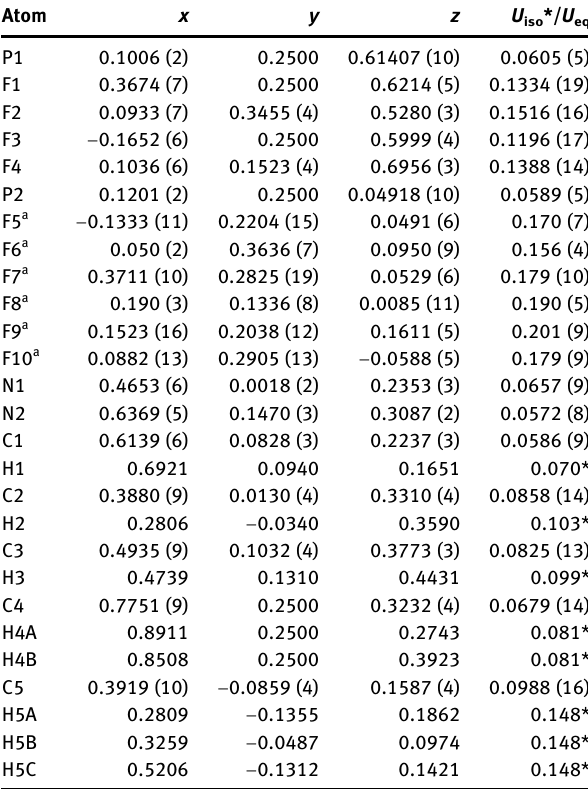
Table  : Fractional atomic coordinates and isotropic or equivalent isotropic displacement parameters (Å 